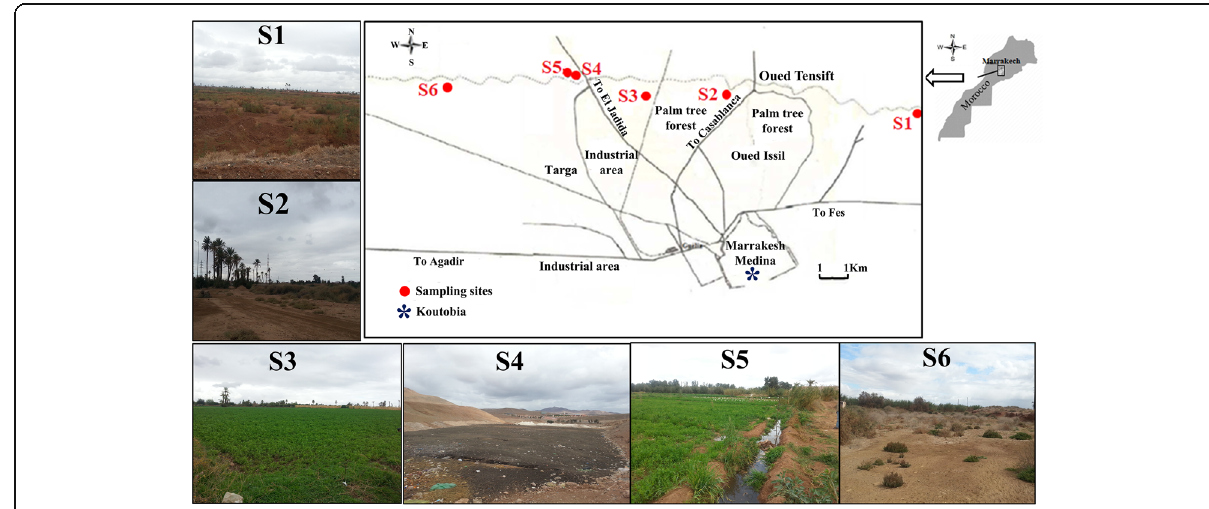
Fig. 1 Location of sampling sites in Marrakech peri-urban area. S1: reference Site; S2: non-cultivated land — construction waste area; S3: Cultivated land — groundwater; S4: non-cultivated land — former dump; S5: cultivated land — treated wastewater; S6: non-cultivated land mine wastes (the map of Marrakesh city is carried out by El Khalil et al.